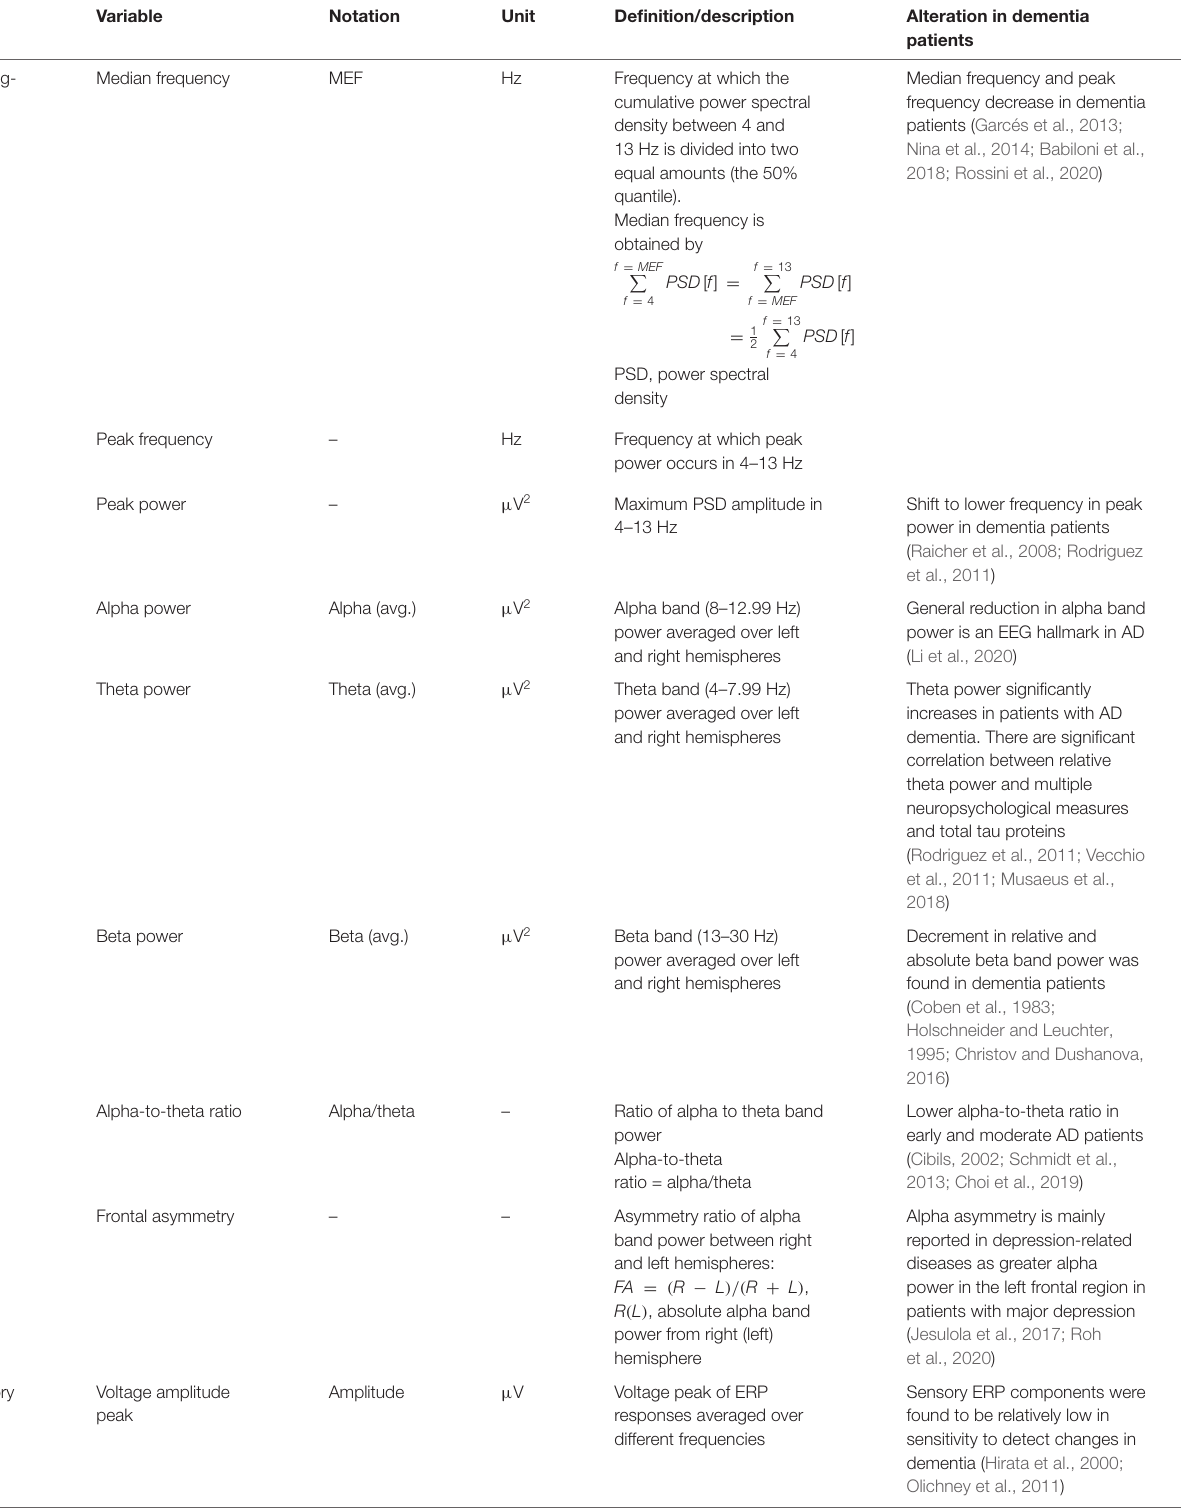
TABLE 1 | EEG/ERP variables considered in this